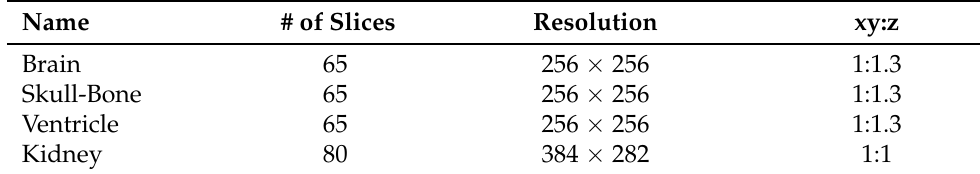
Table 1. Characteristics of input